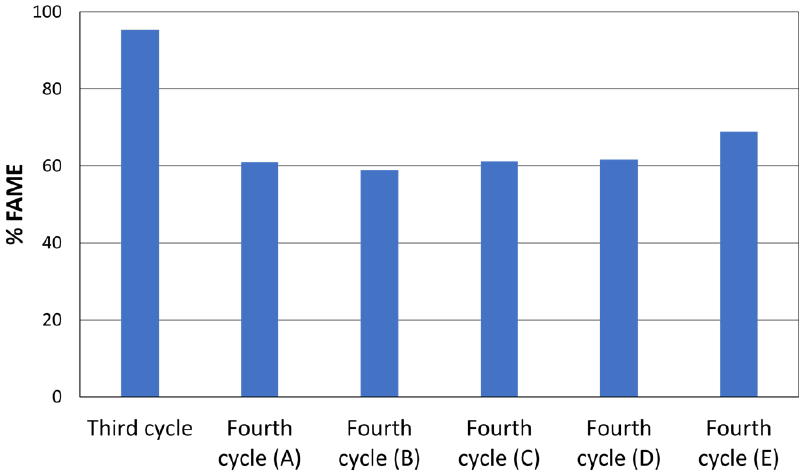
Figure 3. Study of catalyst regeneration (NaNO 3 /SiAl 20/1) after its third use: (bar A) filtering and drying; (bar B) washing treatment (acetone) and drying; (bar C) washing treatment (methanol) and drying; (bar D) two washing treatments (methanol and heptane) and drying; (bar E) washing treatment (methanol and NH 4 OH 5M).